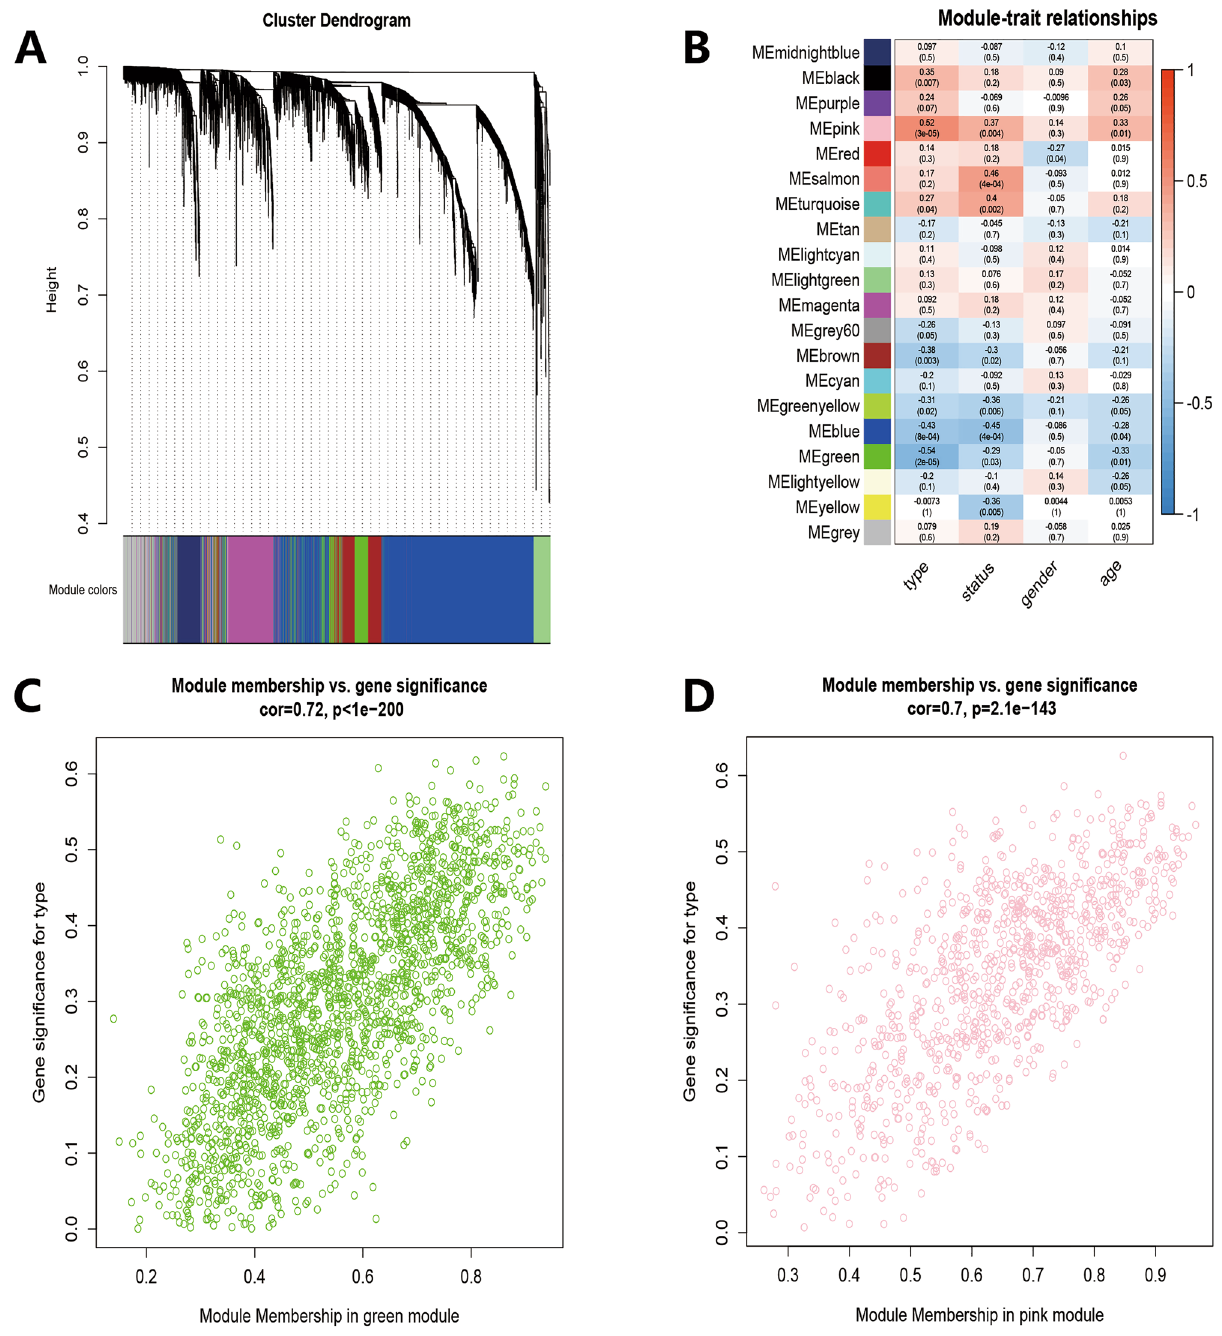
Figure 3. Weighted gene co-expression network analysis. ( A ) Clustering dendrogram of total genes related to IA onset. ( B ) Heatmap shows the relationships between different modules and clinical traits. ( C ) Scatter plot of module eigengenes in the green module. ( D ) Scatter plot of module eigengenes in the pink